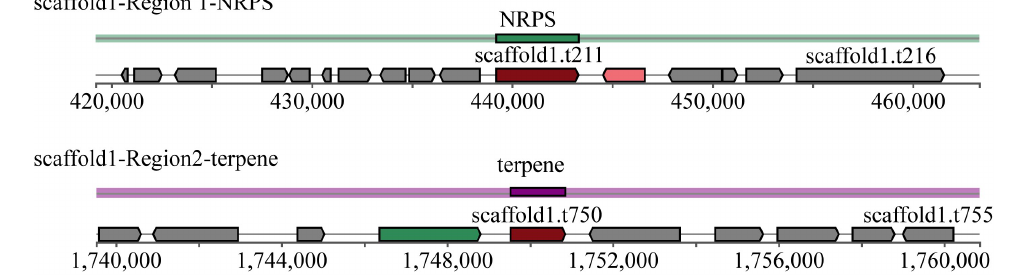
Figure 6. Predicted results of secondary metabolite biosynthesis gene clusters in the Starmerella bacillaris CC-PT4. Table 3. Annotation results of the S. bacillaris CC-PT4 secondary metabolic synthesis gene cluster based on MIBIG.